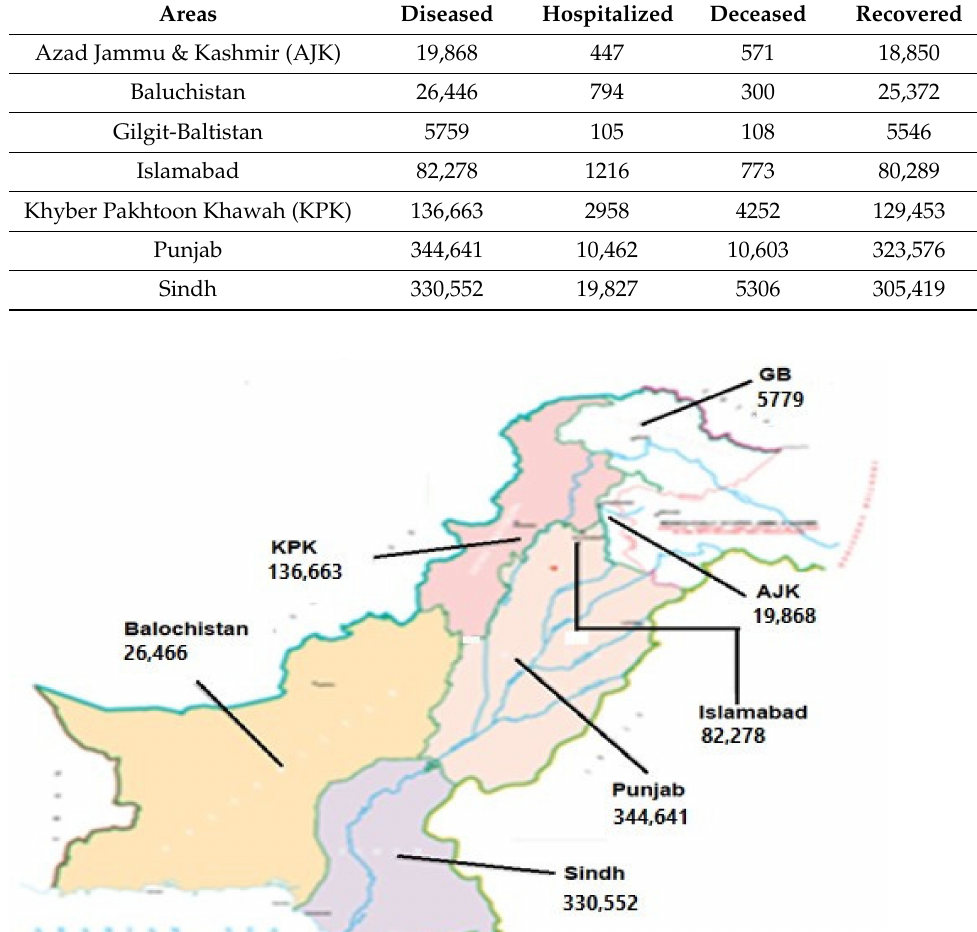
Table 1. The data of COVID-19 taken from the official covid website (http://www.covid.gov.pk, accessed on 16 June 2021) of Pakistan for a period spanning from 3 January 2020 to 16 June 2021.